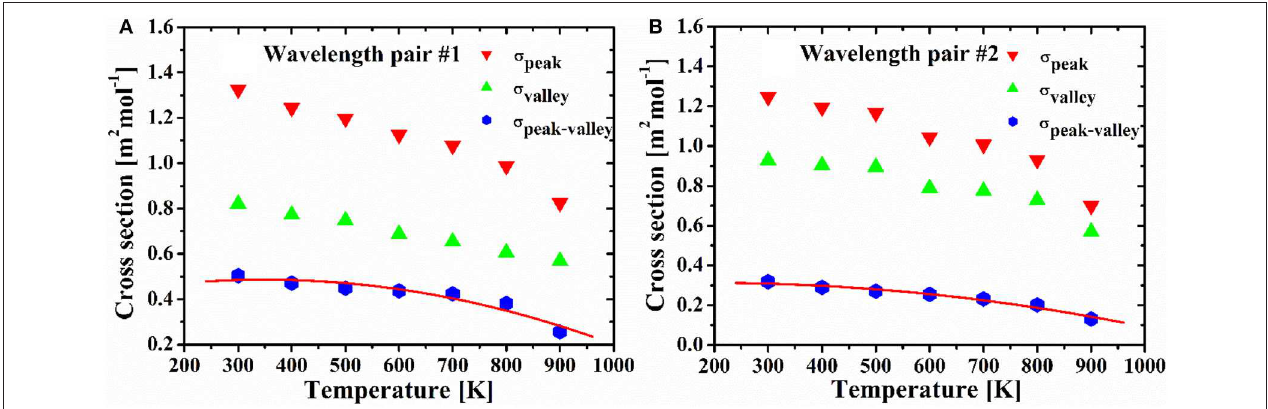
FIGURE 4 | The absorption cross sections of the selected peaks and valleys, and their differential cross sections ( σ peak − valley ) of wavelength pair #1 (A) and #2 (B) as a function of temperature at 1 atm.